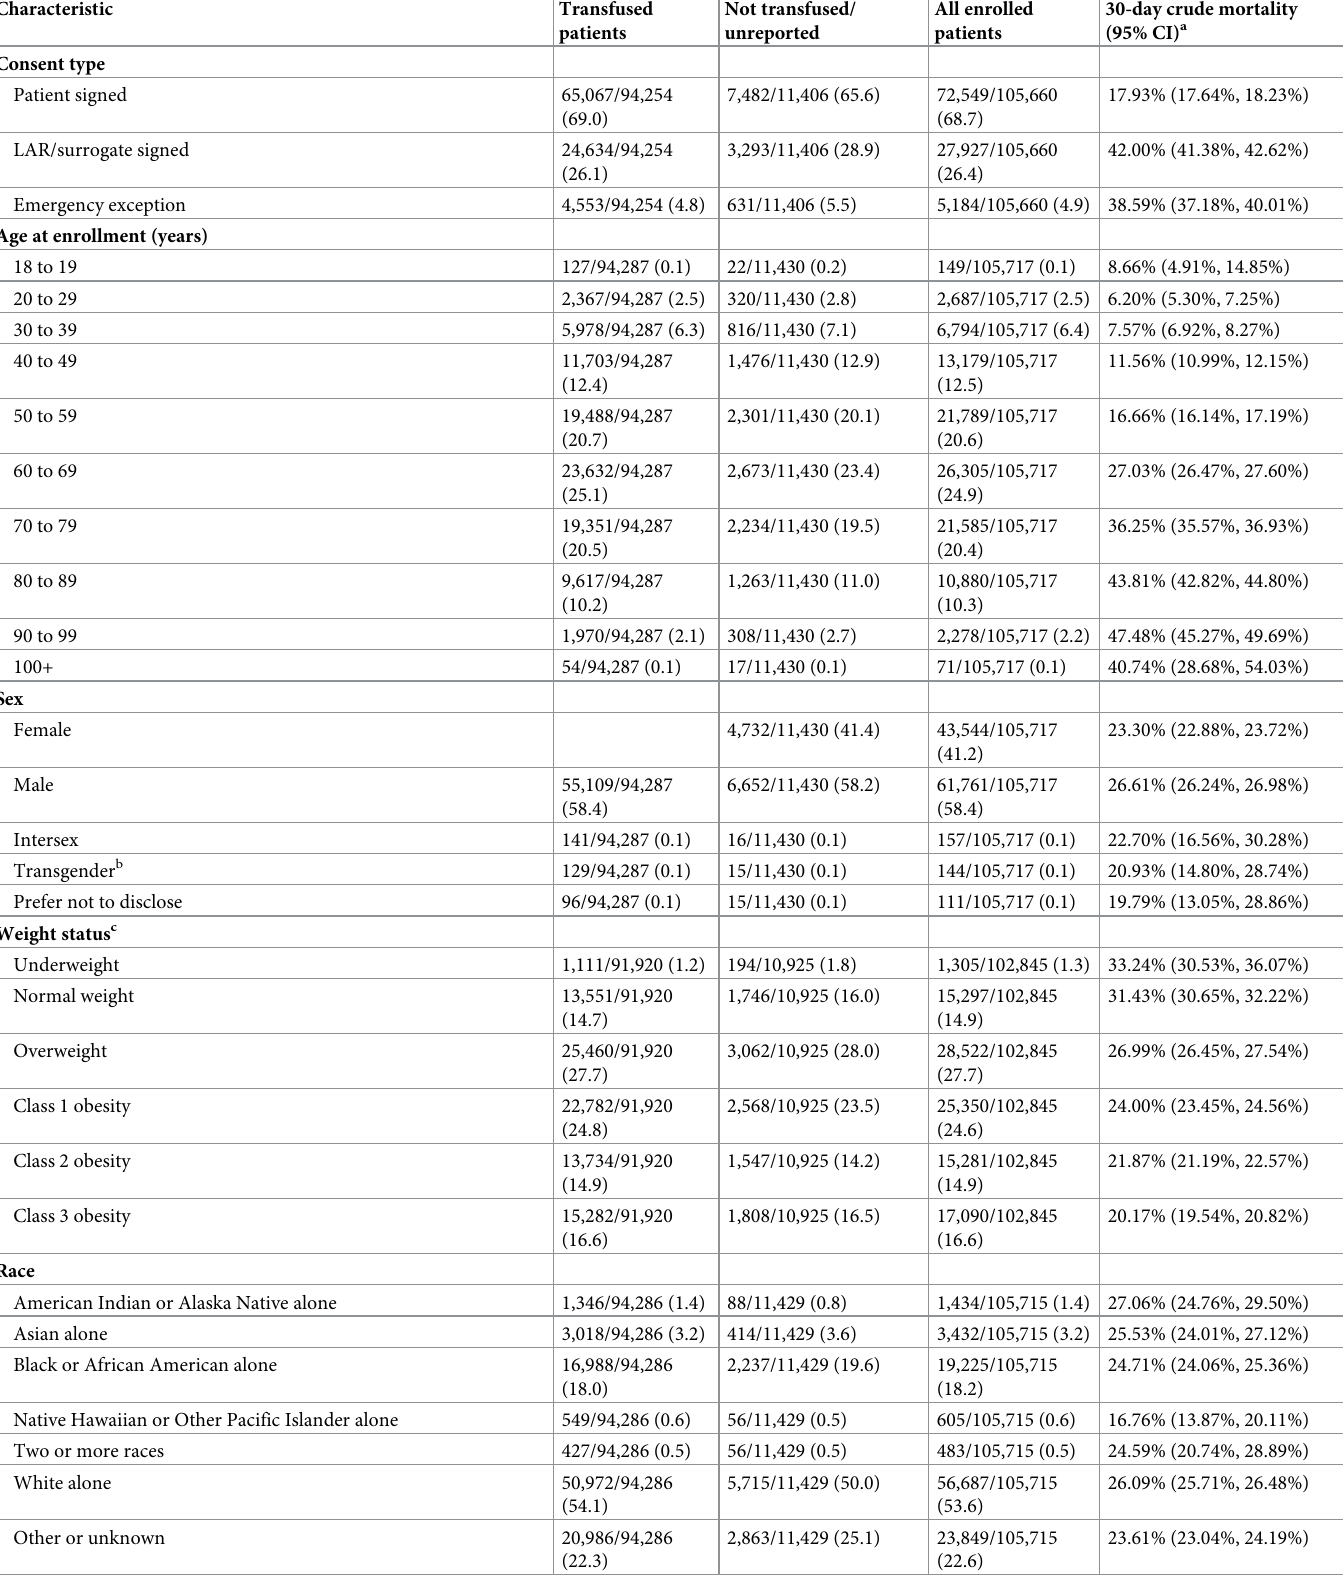
Table 1. Characteristics and crude mortality rates of patients with COVID-19 who were enrolled in the US Expanded Access Program for convalescent plasma.